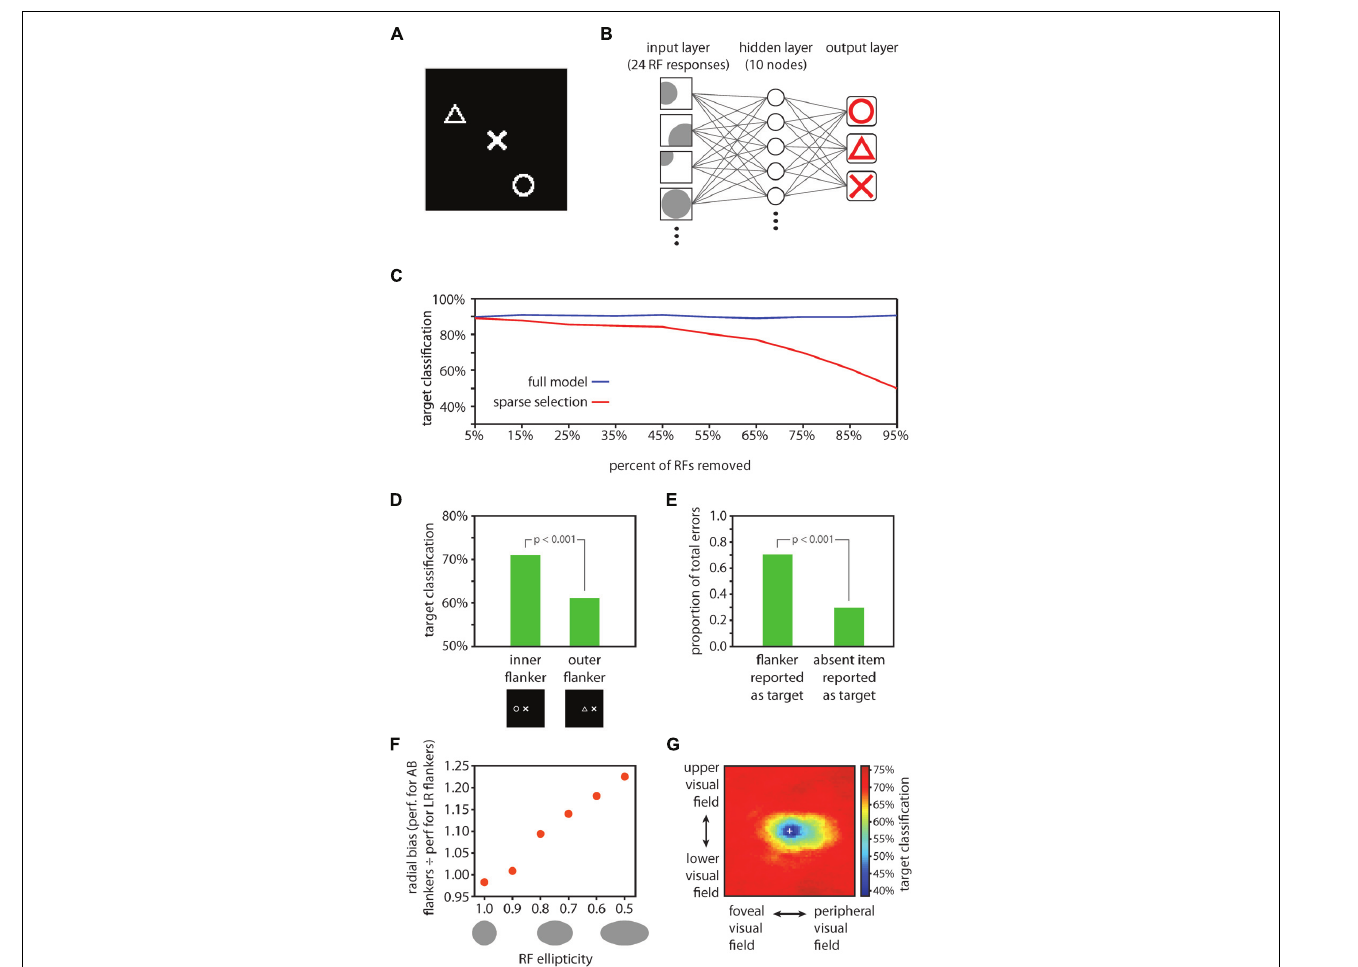
used to test the inner-outer asymmetry, we found that when the model made a classification error, it was significantly more likely to report the flanker as the target than to report the symbol that was absent from the display ( p < 0.001).This is consistent with human performance; observers frequently substitute a flanker for the target in a crowded display (Wolford, 1975; Chastain, 1982). (F) We varied RF ellipticity in the model from 1.0 (circular) to 0.5 (half as tall as wide). For each value of RF ellipticity, we tested model performance with images in which flankers were positioned either to the left and right of the target (LR flankers; positioned along the radial dimension relative to the fovea) or above and below the target (AB flankers; positioned along the tangential dimension).We computed the ratio of performance when AB flankers were present to performance when LR flankers were present as a measure of radial bias in model performance. Radial bias increased monotonically as RFs became more elliptical, demonstrating that asymmetrically shaped RFs are a plausible source of the radial bias in crowding. However, the validity of the HSS model does not hinge on elliptical RFs. Other potential sources of the radial bias in crowding such as saccadic influences on the development of lateral connections (Nandy andTjan, 2012) could be similarly integrated into the HSS model. (G) A visualization of the crowding zone based on the neural network model performance (the region of space around the target within which the presence of a flanker crowds the target).The white cross marks the location of the target; model performance was tested with a single flanker positioned at every possible location within the display. Here, we expanded the size of the display space by 50% relative to previous tests of model performance in order to visualize the full extent of the crowding zone.The visualized crowding zone is reminiscent of the elongated spatial interaction zones found byToet and Levi